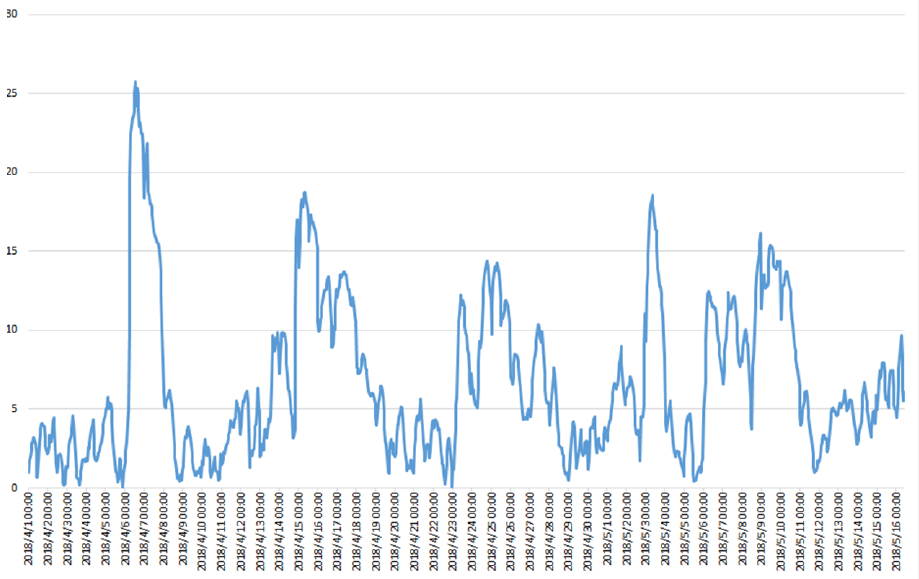
Figure 18. Wind velocity chart between 1 April and 16 May in 2017.